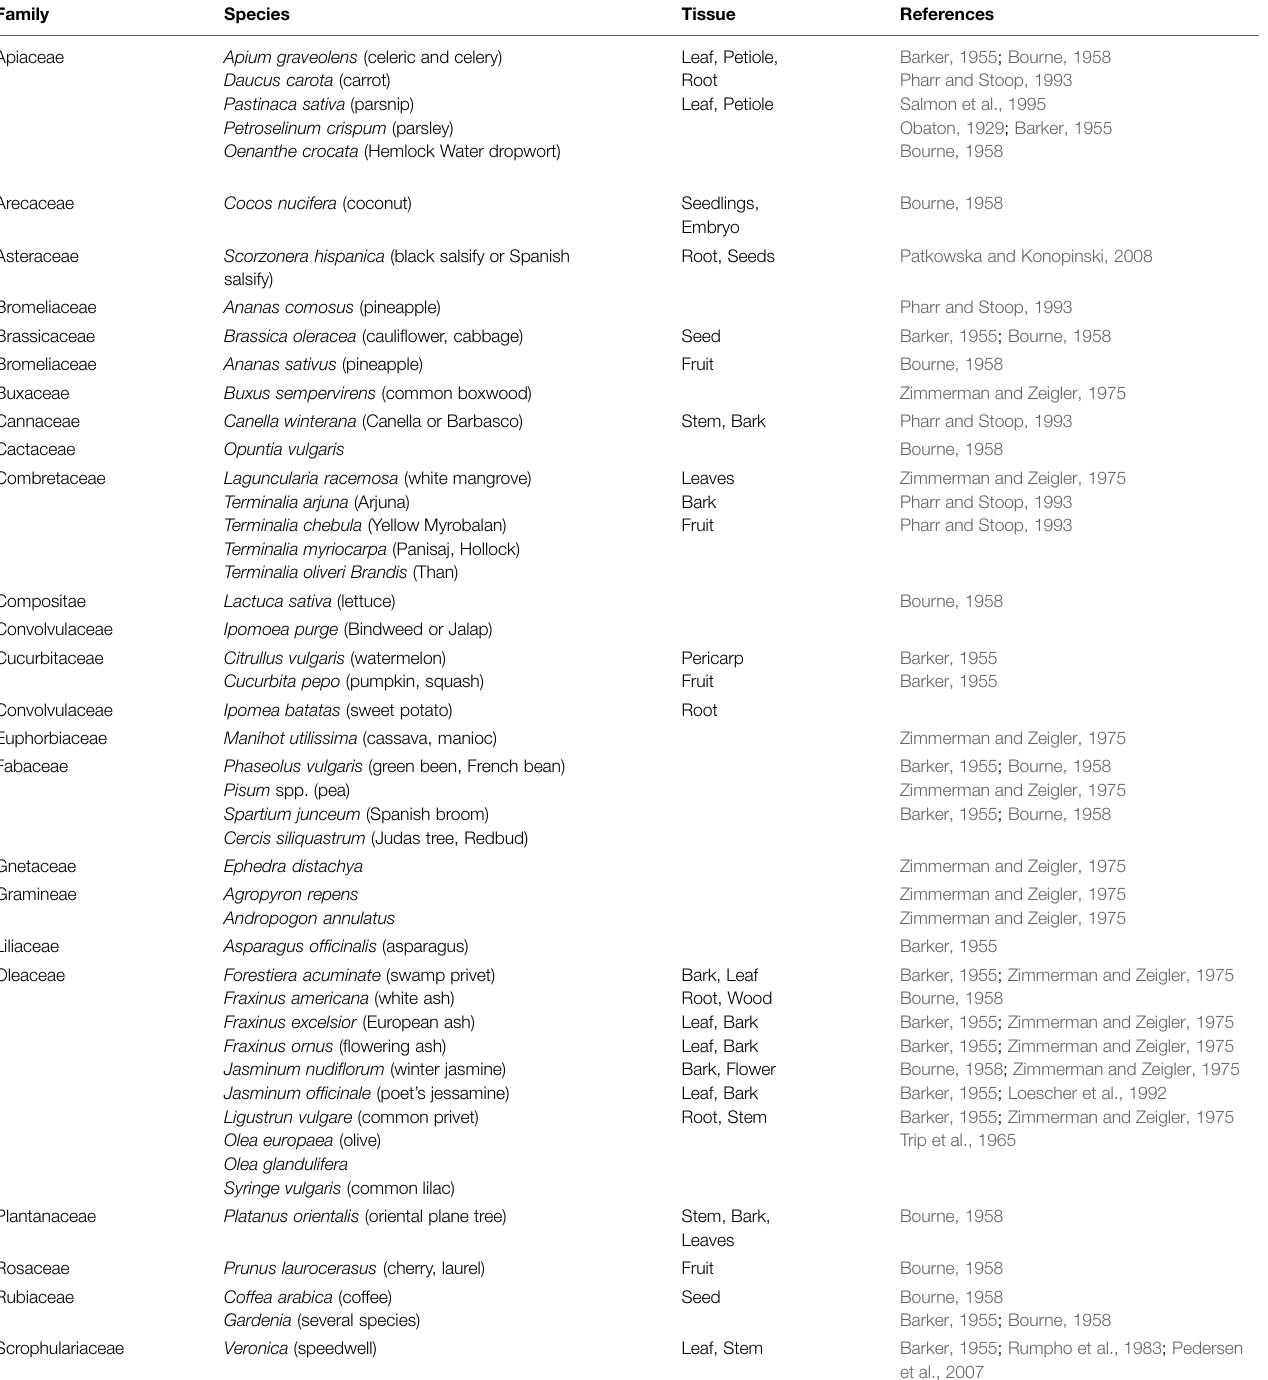
TABLE 1 | Representative plants that contain